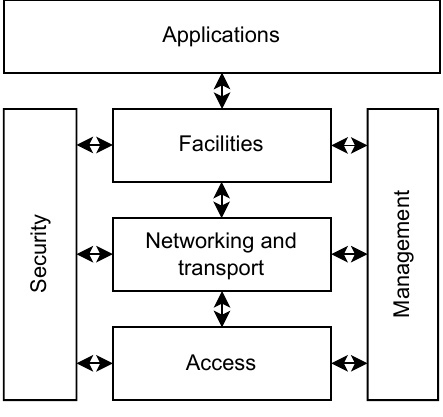
Figure 3. ITS four-layer architecture